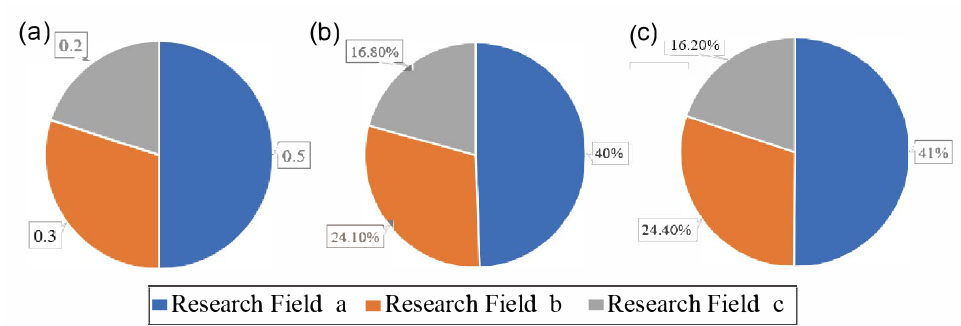
Figure 7. The authors proportion of the fields a , b , and c covered by important articles in the COVID- 19 field is compared with the correlation strength between the fields a , b , c , and the COVID-19 field. ( a ) The correlation strength of fields a , b , and c with COVID-19, respectively. ( b ) The authors proportion of the fields a , b , and c covered by the articles with the top 5 largest connectivity degrees in the COVID-19 field. ( c ) The authors proportion of the fields a , b , and c covered by the articles with the top 6 largest connectivity degrees in the COVID-19 field.